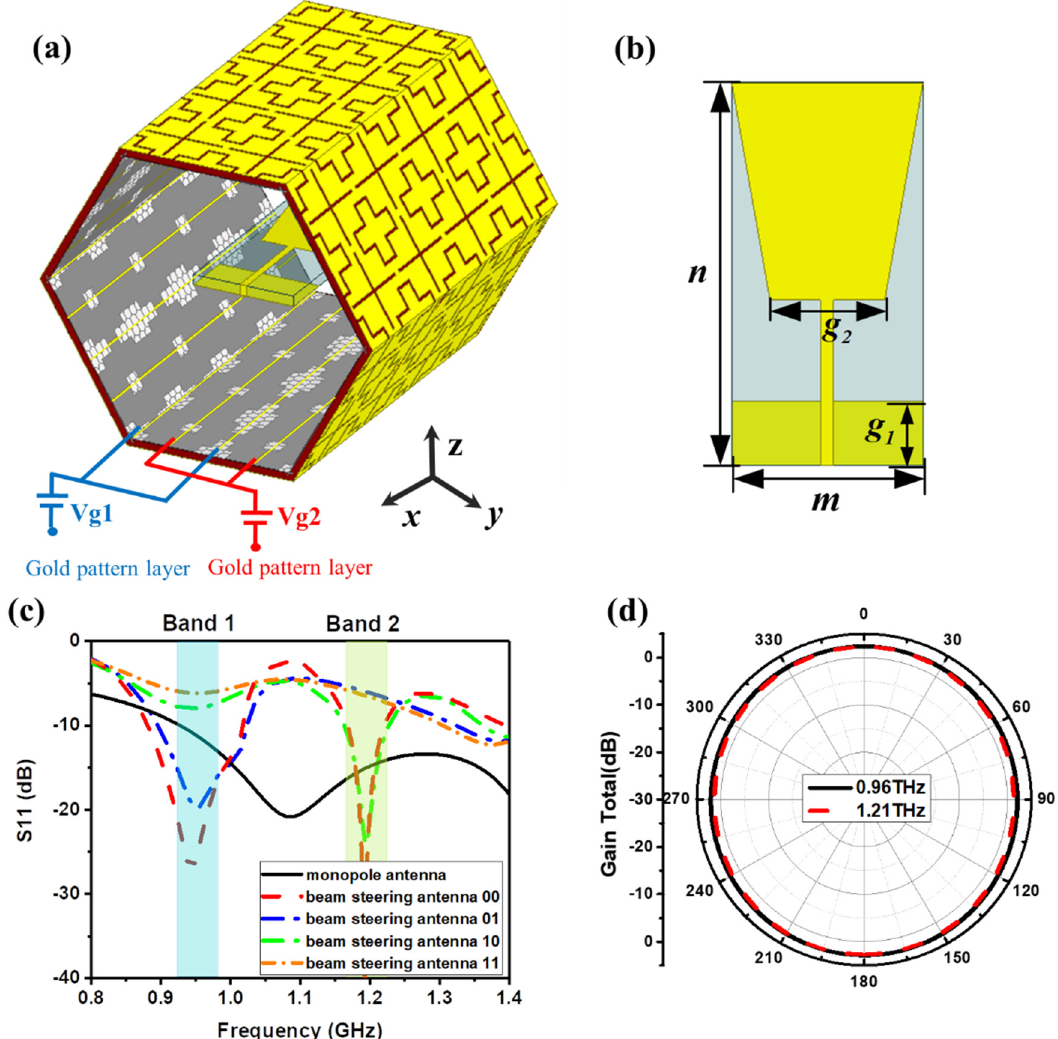
Fig. 4. (a) 3D view of the proposed dual-band beam steering THz antenna. (b) Geometry of the broadband omnidirectional monopole source antenna. The relevant geometrical dimensions are m =72, n =144, g 1 =33.6, g 2 = 43.2, all in m m. (c) Re fl ection coef fi cients of the broadband omnidirectional source antenna and the dual-band beam steering THz antenna under different states. (d) Radiation patterns of the omnidirectional source antenna on the horizontal plane at two